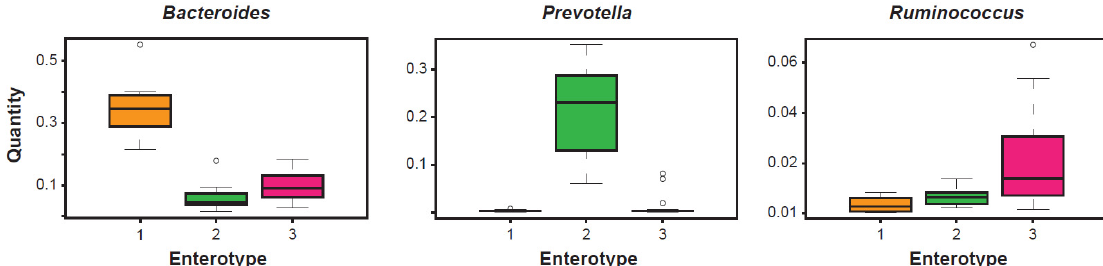
Figure 1. The analysis of gut microbiota of adult and healthy subjects demonstrates the existence of three clusters, or enterotypes, centered on a main driver, respectively Bacteroides , Prevotella , and Ruminococcus , measured for its relative abundance. Modified from [14].